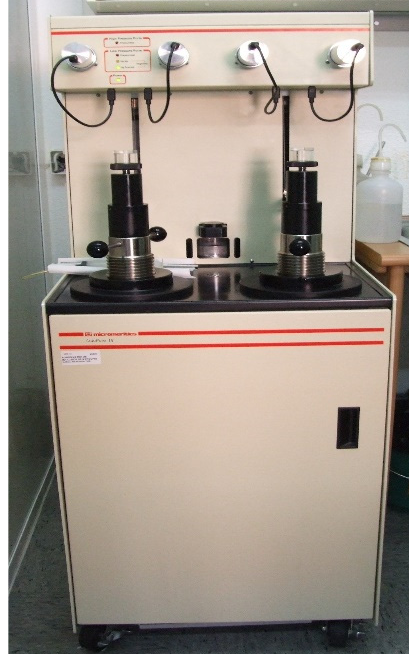
Figure 3. Mercury intrusion porosimetry (MIP).